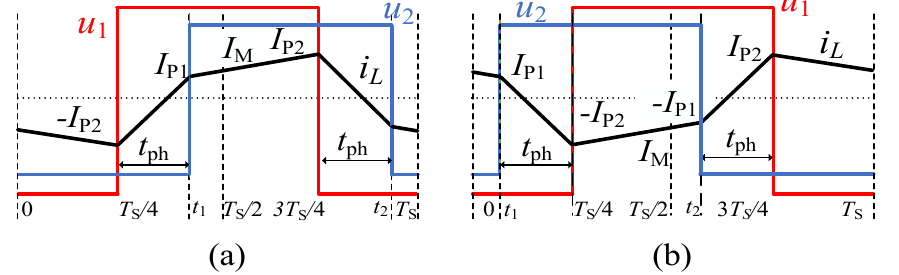
Figure 2. Waveforms of IBDC at steady state for CSPS modulation: ( a ) forward power transmission ( P > 0), ( b ) reverse power transmission ( P < 0).